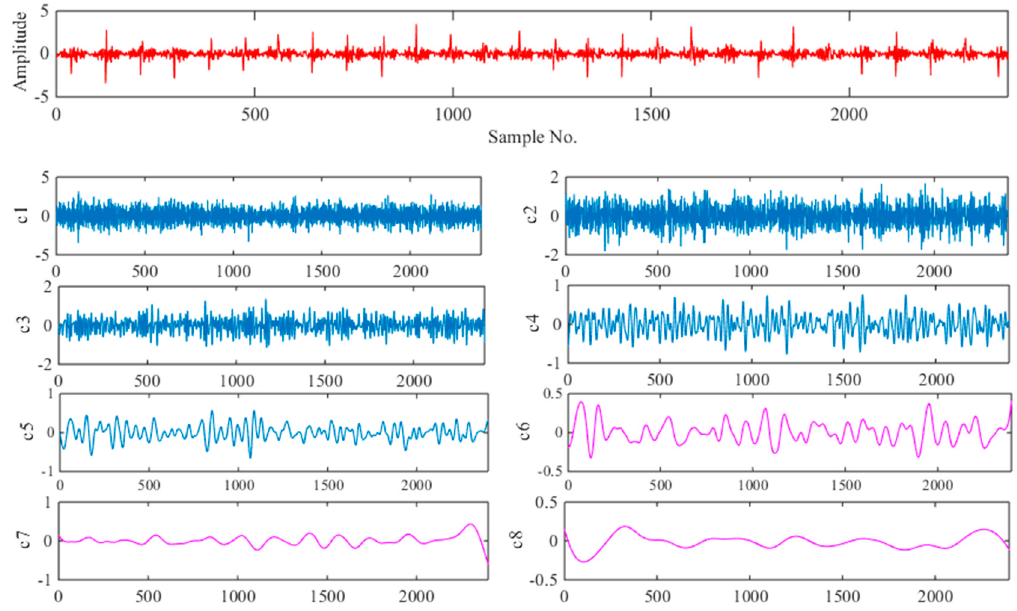
Figure 11. Decomposed signal with outer race fault using EEMD.